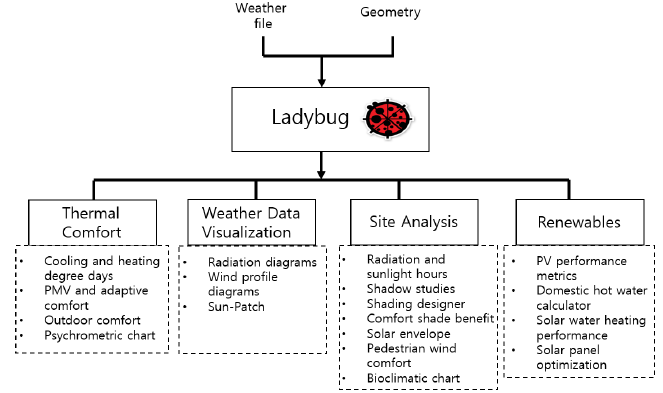
Figure 8. Ladybug Workflow and Functions.